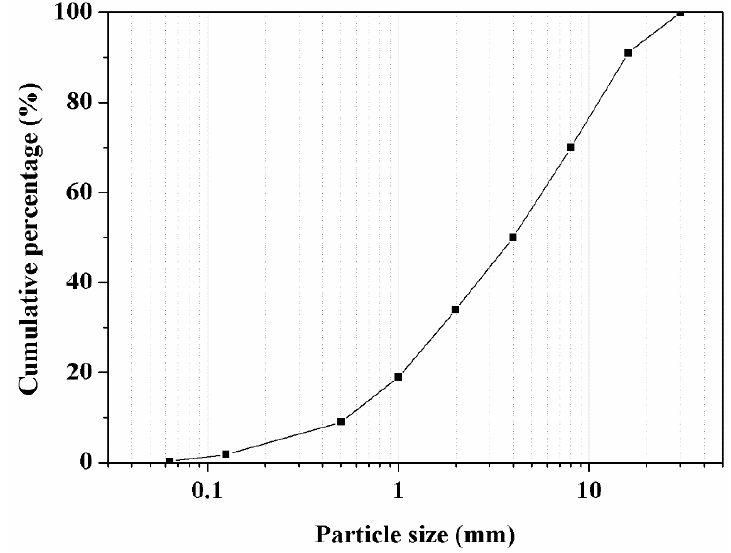
Figure 1. Particle size distribution of weathered bottom ash (WBA).